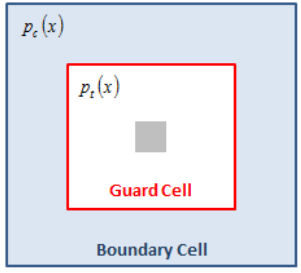
Figure 3. CFAR stencil representation. Different types and sizes of guard and boundary cells can be utilized in the detection process. The most common choices are rectangular types of cells, the dimensions of which depend on the data resolution and the size of ship targets that need to be detected in the SAR data. If G is the size of the guard cell and B is the size of the boundary cell, a value of 23 GB  is experimentally found to provide good detection results.